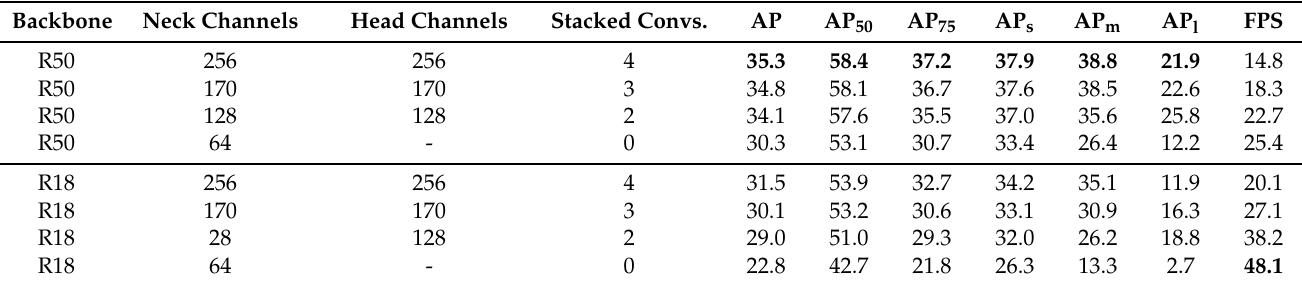
Figure 5. Comparing RetinaNet with different backbones. The ResNet family shows a good accuracy- runtime-trade-off in almost all circumstances. Only in the high FPS regime RegNetX achieves a higher precision with the same runtime comaped to ResNet-18. However, further experiments have shown that ResNet-18 is better when other improvements are also applied. Table 11. Comparing RetinaNet (ResNet-50 and ResNet-18) with different head and neck configurations. The first two steps of downscaling the head and the neck lead to a significant speed-up with both backbones while only slightly impairing the precision. Further reducing the number of channels to 64 and removing all stacked convolutions in the head leads to a significant drop in accuracy. Thus we do not consider this setting for further